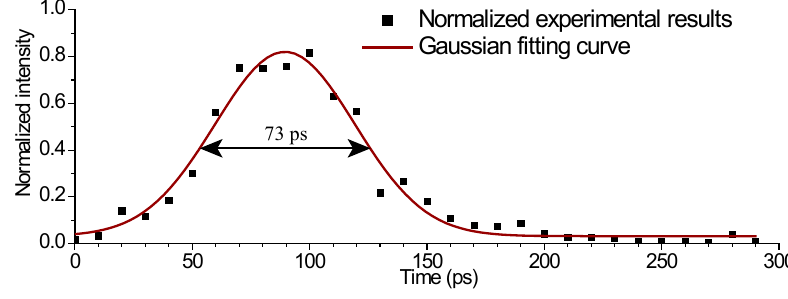
Figure 8. Exposure curve of the designed image sensor.